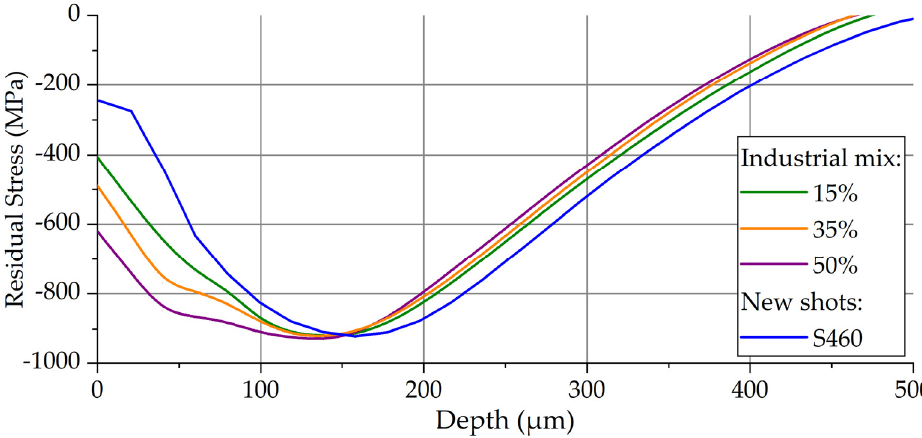
Figure 13. Residual stress profiles for various industrial shot mixes, alongside S460 shot mix.